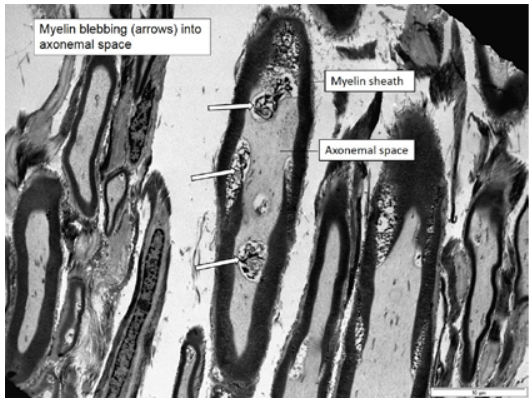
Figure 5: Electron microscopy of ulnar nerve demonstrating axonal degeneration with dissociation of the myelin sheath surrounding the axons and blebbing of myelin into the axonal space